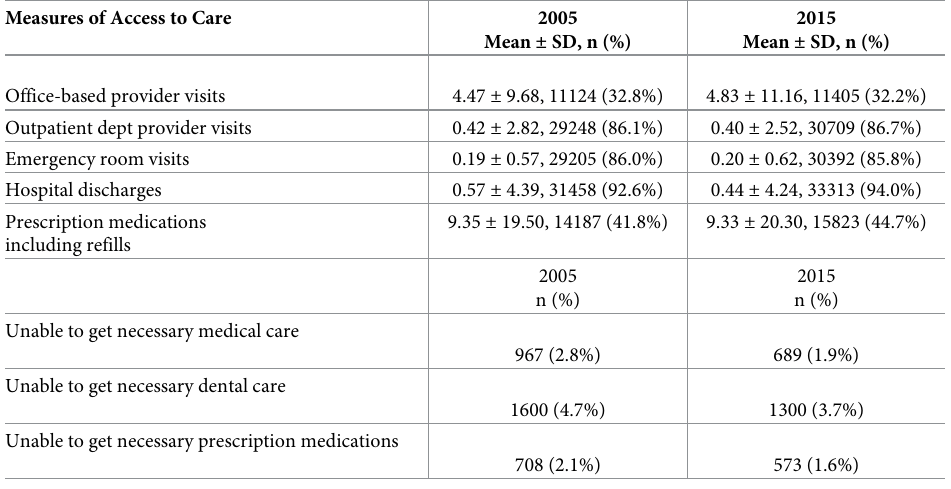
Table 1. Measures of access to care: 2005 vs.